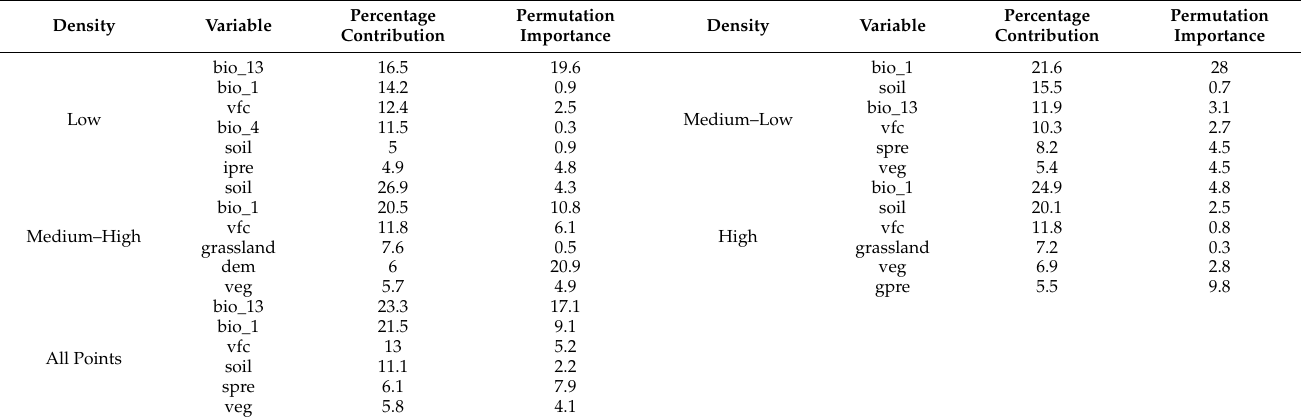
Table 4. The response variables, percentage contributions and permutation importance of the major habitat factors under the three